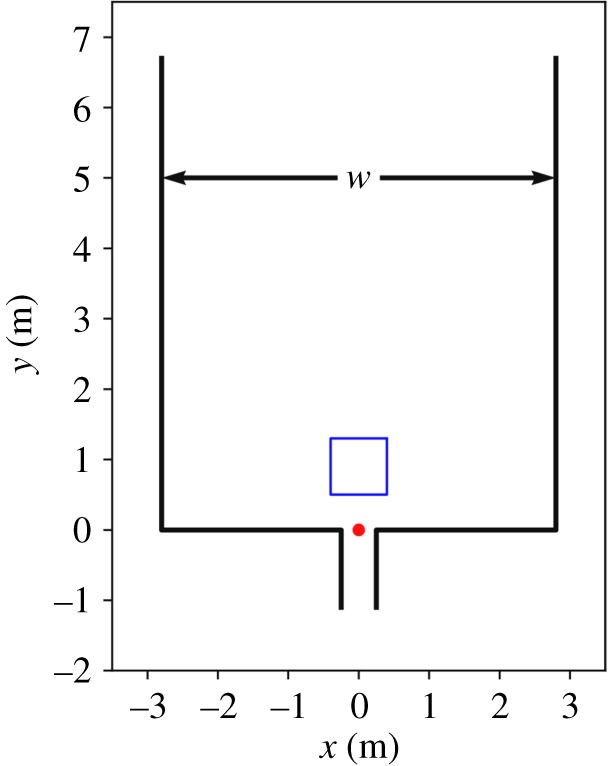
Sketch of the experimental set-up; w is the corridor width, the red dot is the target at the entrance of the gate and the blue square indicates the measurement area.